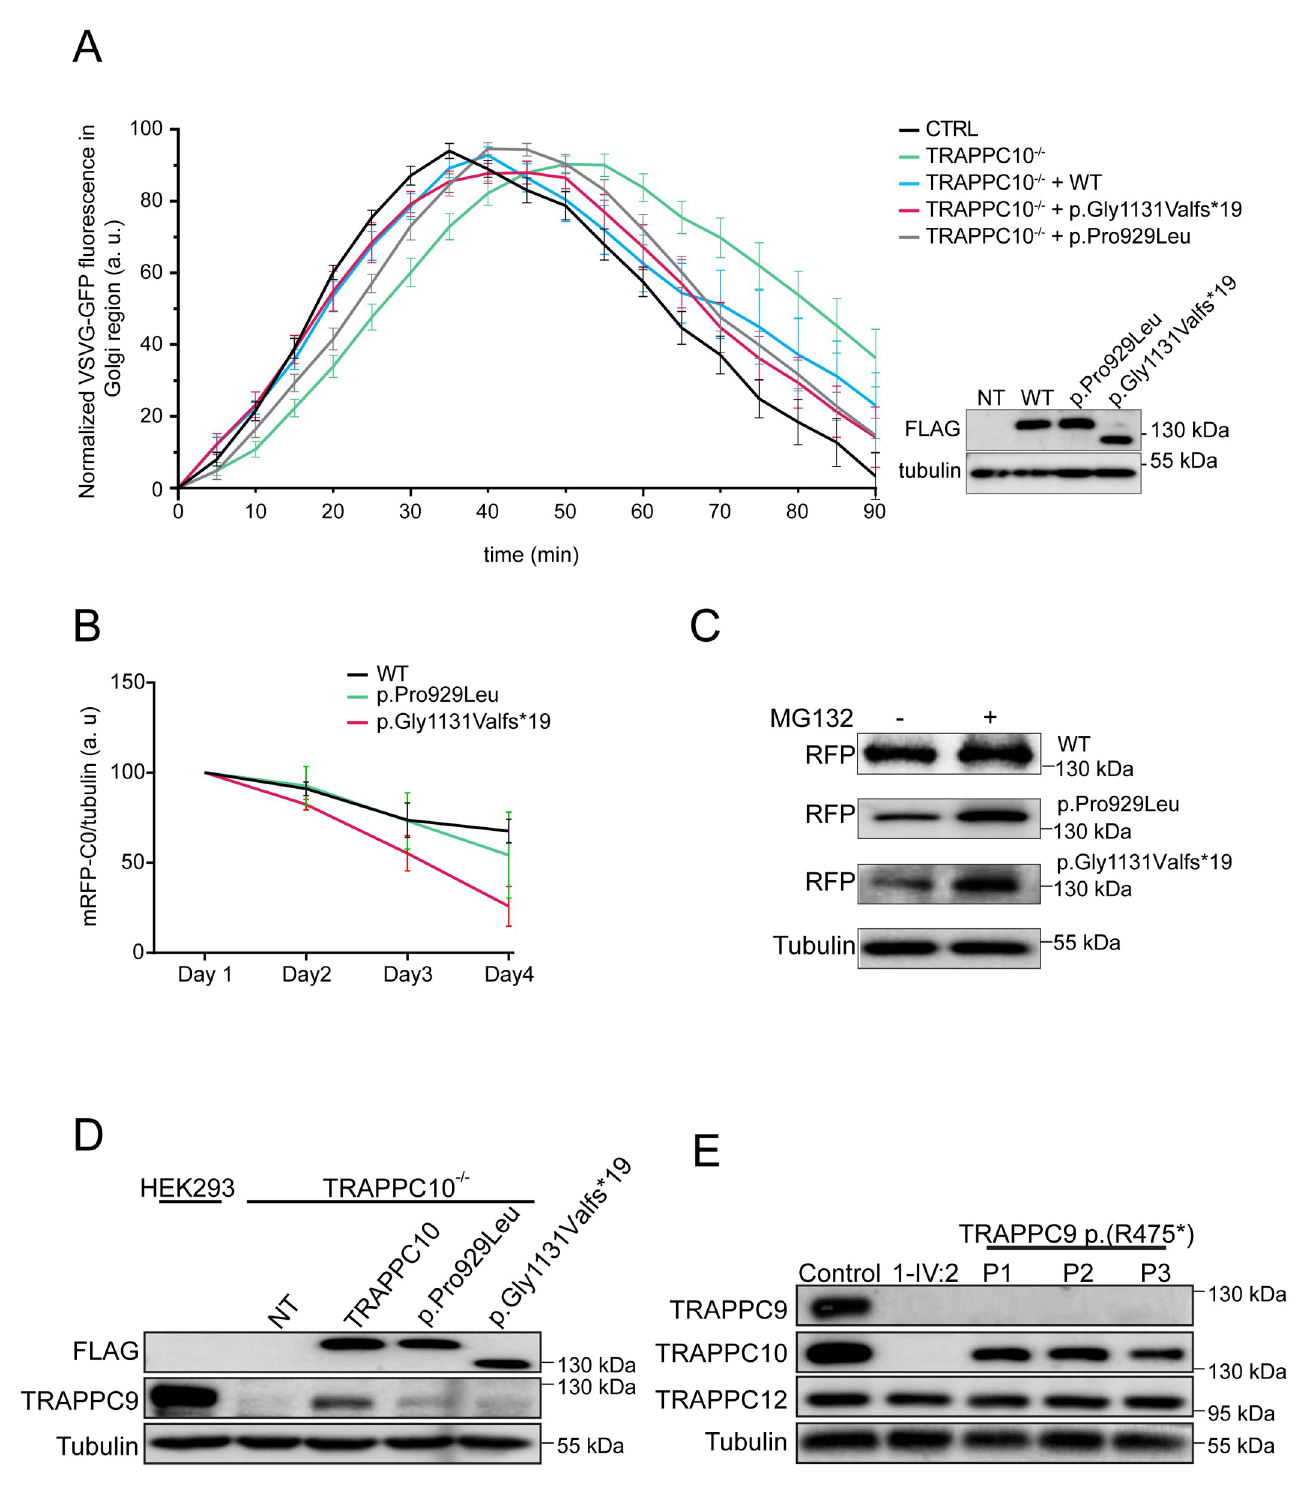
Fig 3. Cells devoid of TRAPPC10 display a membrane trafficking defect and lack detectable levels of TRAPPC9. ( A ) Wild type HEK293 cells or TRAPPC10 -/- cells either not transfected or transfected with FLAG-tagged wild type TRAPPC10 or one of the TRAPPC10 variants indicated were infected with VSVG-GFP